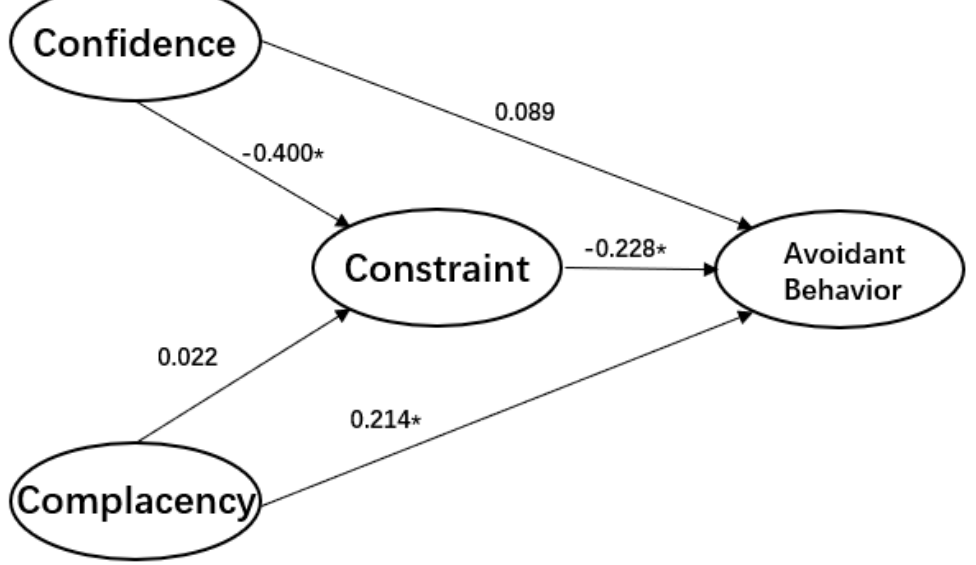
Figure 3. The estimations of conceptualized 3C-avoidant behavior model (China), * p = 0.00.